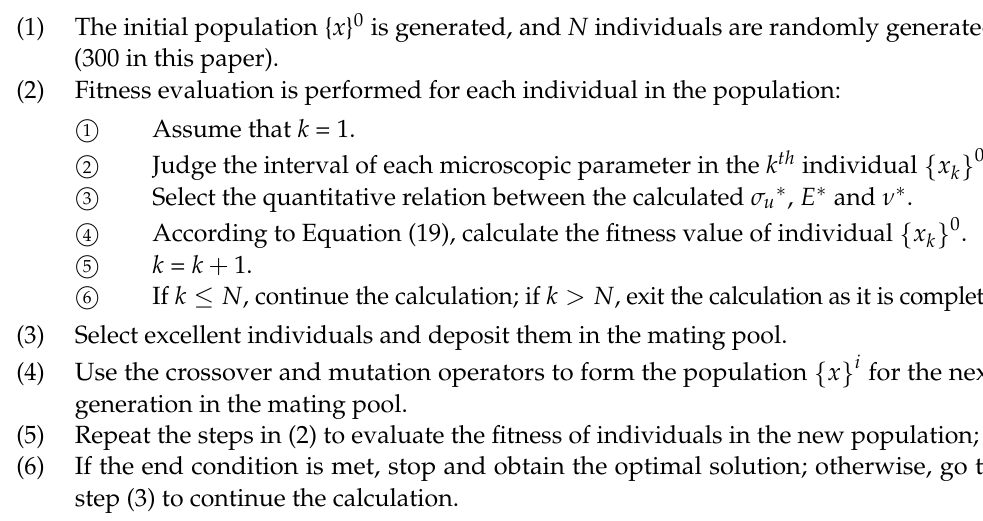
Figure 13. The flow of the algorithm to calibrate the microscopic